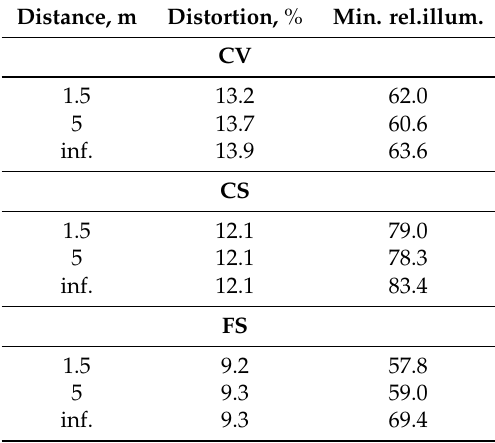
Table 2. Auxiliary imaging performance